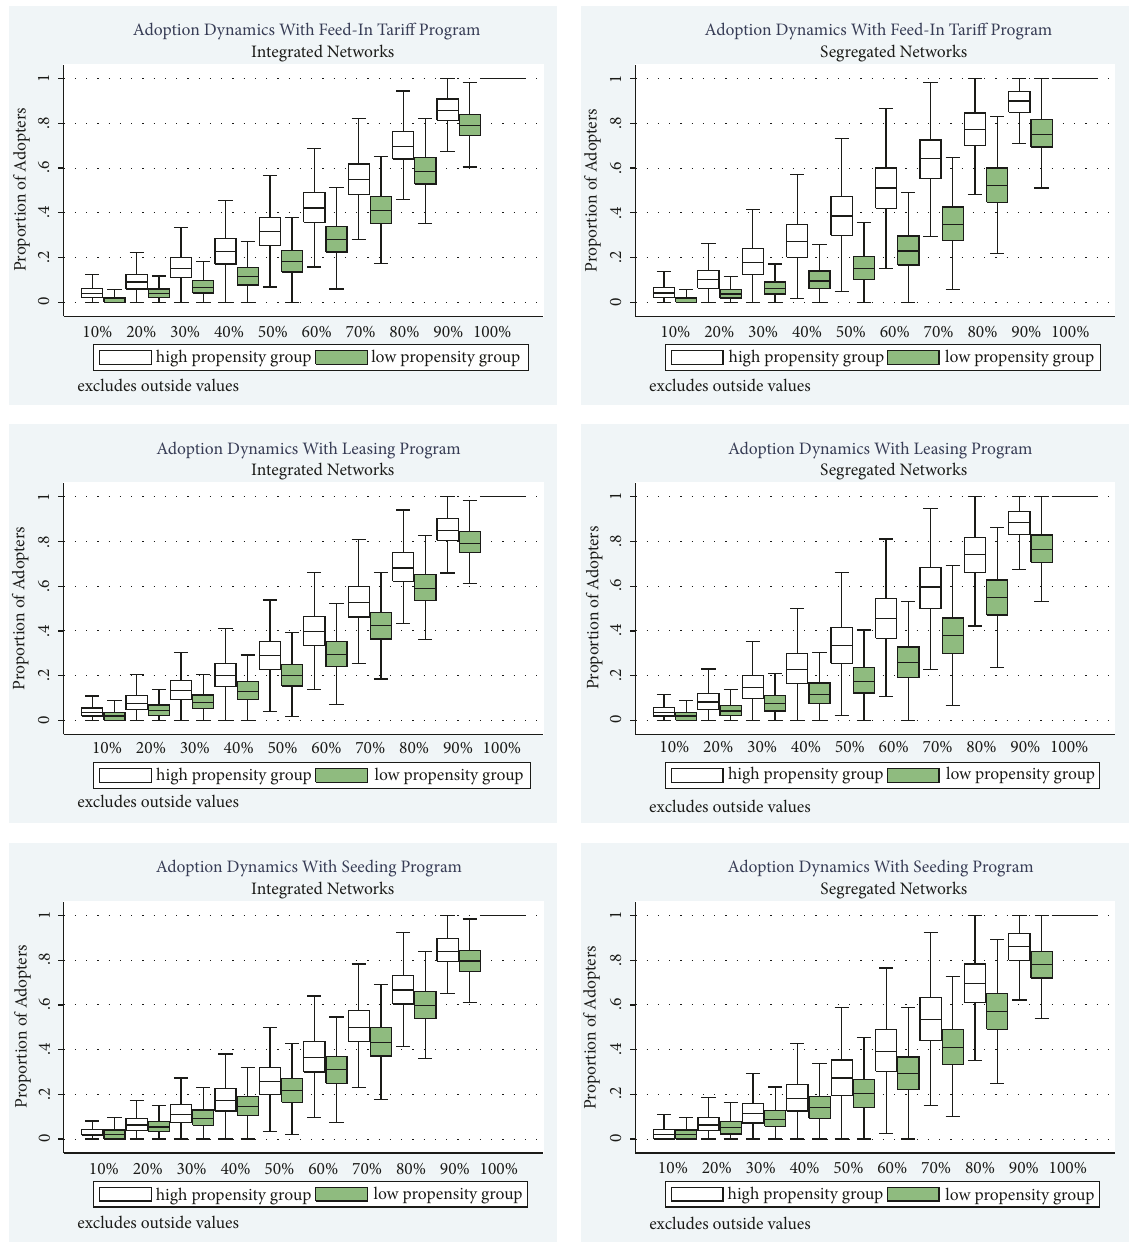
Figure 5: Realized adoption dynamics under various incentive